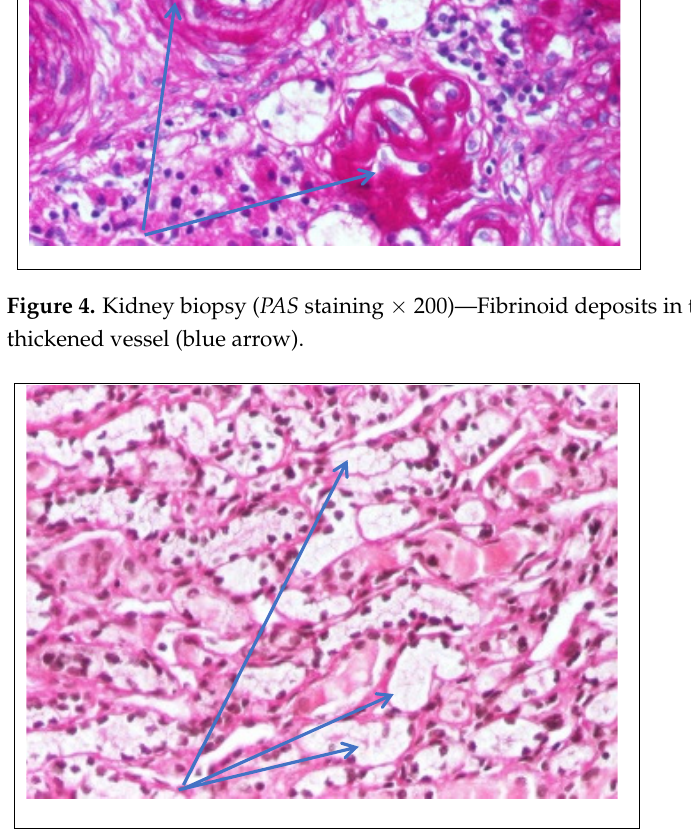
Figure 5. Kidney biopsy ( hematoxylin - eosin staining × 200)—Distal tubes with intracytoplasmic vacuoles (blue arrow).